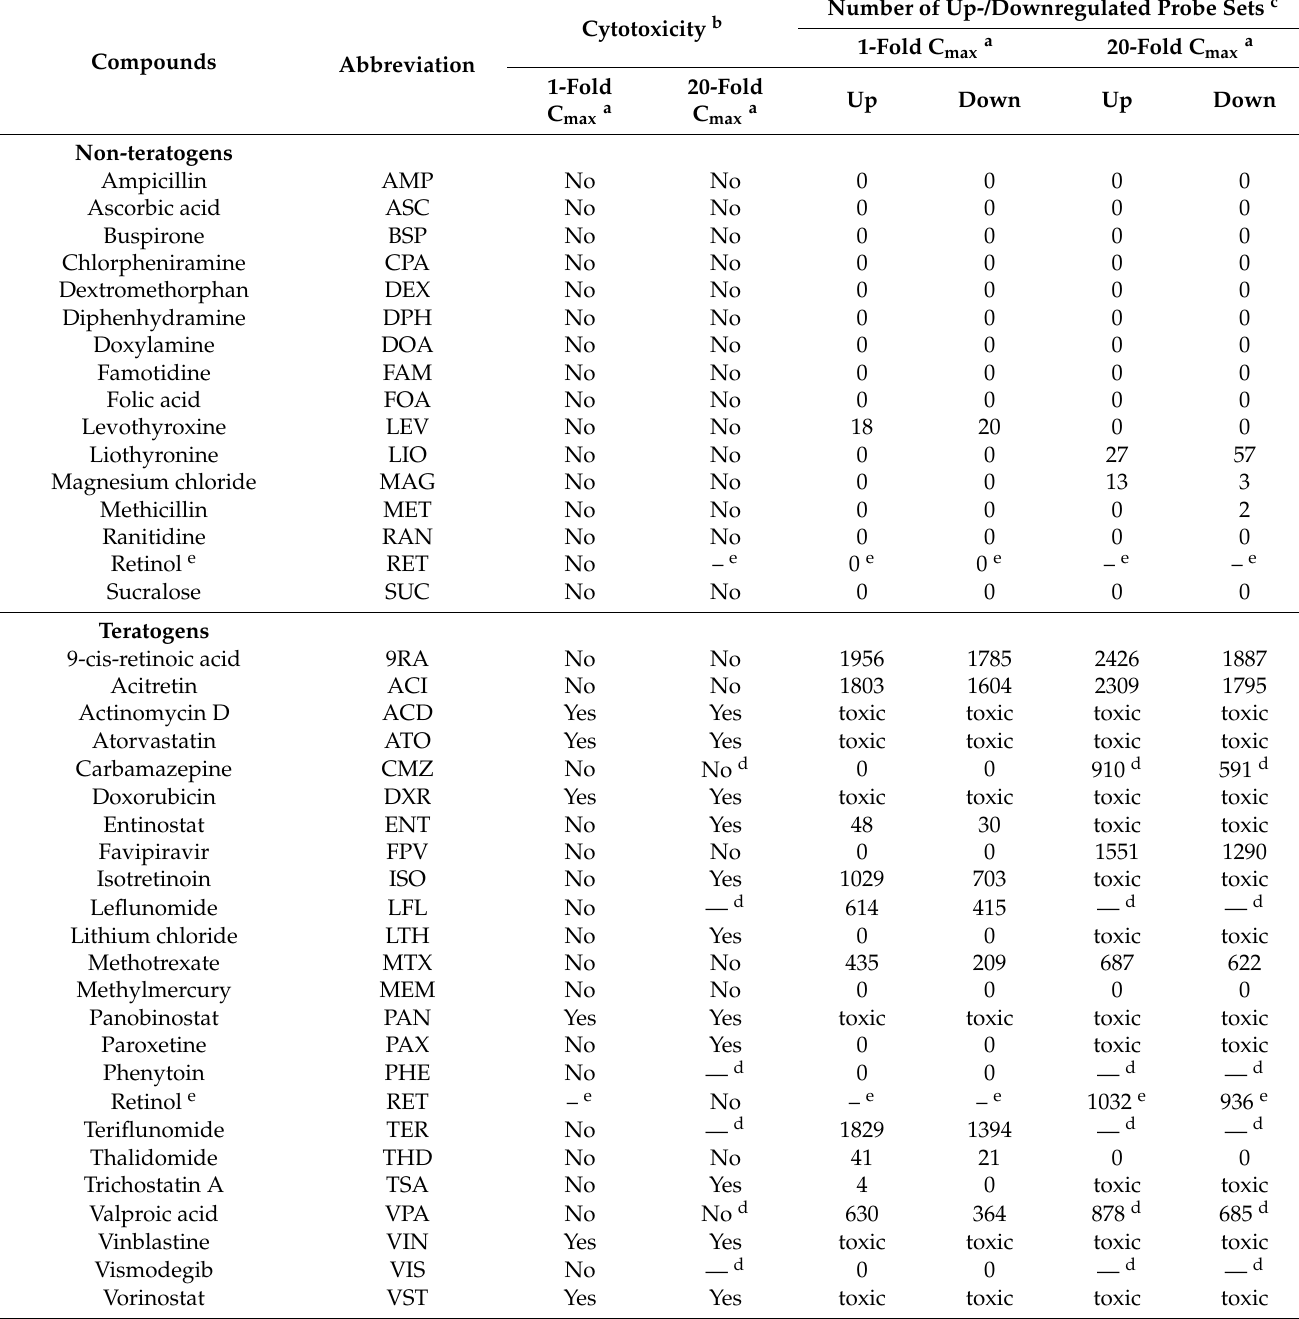
Table 2. Cytotoxicity and number of significantly deregulated probe sets in compound-exposed cells in the UKN1